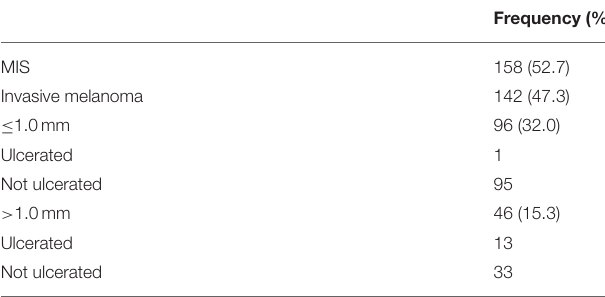
TABLE 1 | Distribution of melanomas included in the test